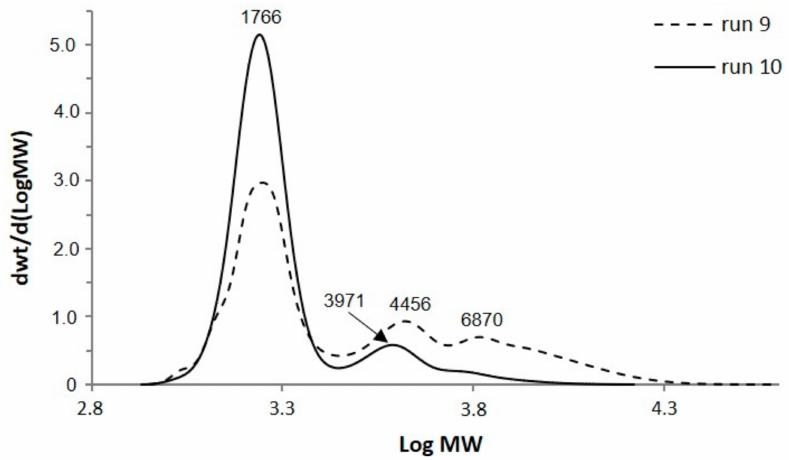
Figure 3. SEC chromatograms of bio-polyols from ESO and 3-phenyl butyric